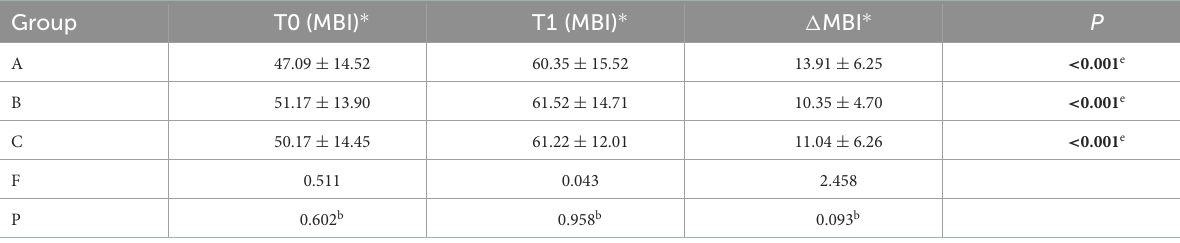
TABLE 6 Comparison of surface electromyographic amplitude (sEMG) of the wrist dorsal extensor muscle group before and after treatment among the three groups. Group T0 (sEMG) ∗ T1 (sEMG) ∗ 1 sEMG ∗ P A 16 (24) < 0.001 c